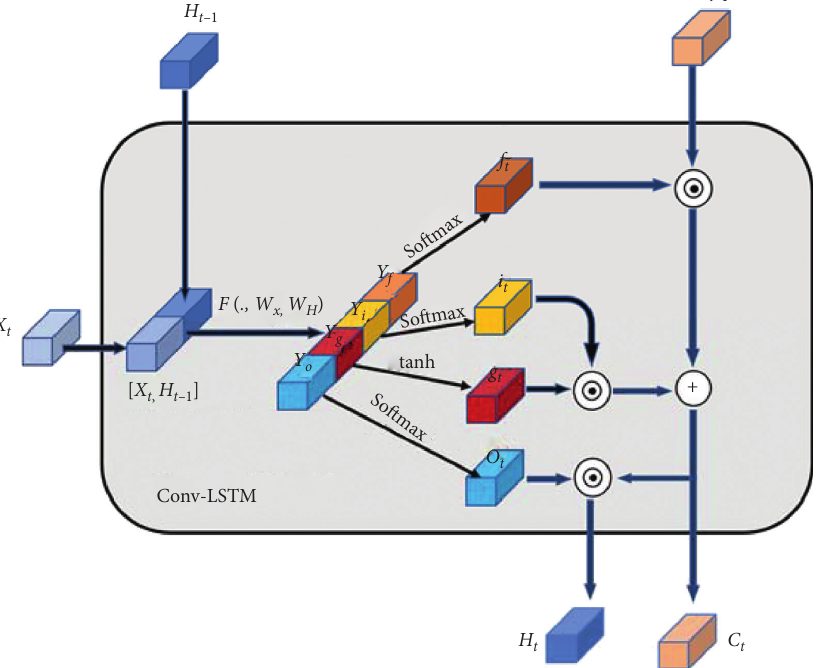
Figure 6: Conv-LSTM